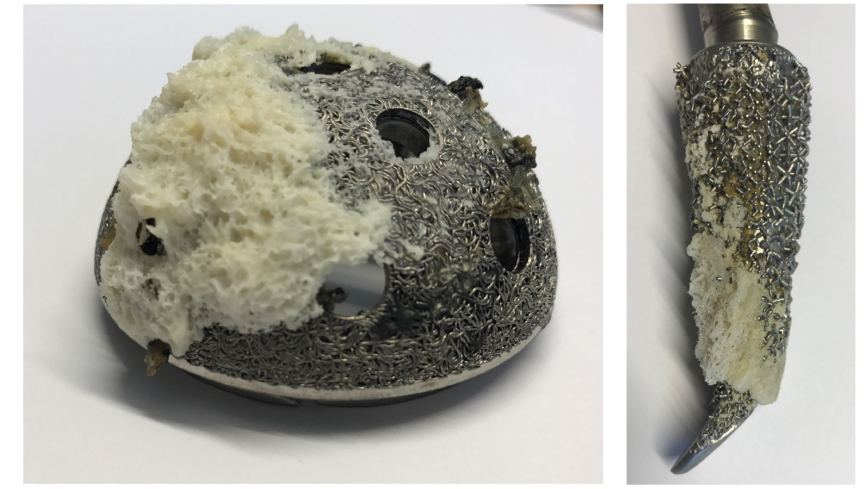
Figure 3. Macro- and microstrucured titanium implants show excellent biomechanical integration into bone in long-term. This implant-to-bone strength is higher than within the adjacent cancellous bone leading to intra-bone fracture during explantation. Here, de novo bone formation (contact osteogenesis) is based on micro-mechanical interdigitation of the surface with the material surface. It is believed that nanostructure titanium surfaces accelerate the initial phase of osteointegration leading to early full weight bearing even in poor bone quality. In contrast, the “bone-bonding phenomenon” is based on a chemical interaction of collagen, from the adjacent bone interdigitating with the chemically active surface of the implant